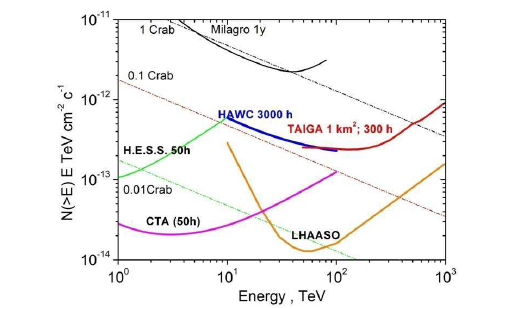
Figure 5. Integral sensitivity for detection of point